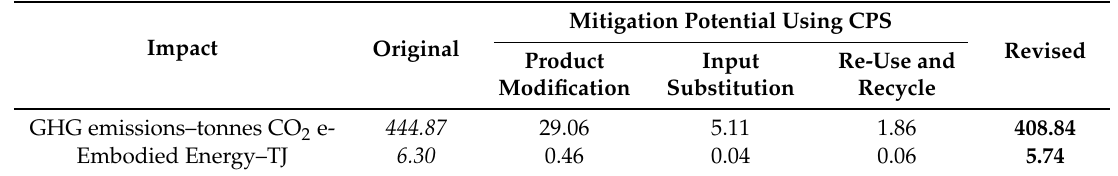
Table 6. Summary of mitigation potential after implementation of cleaner production strategies